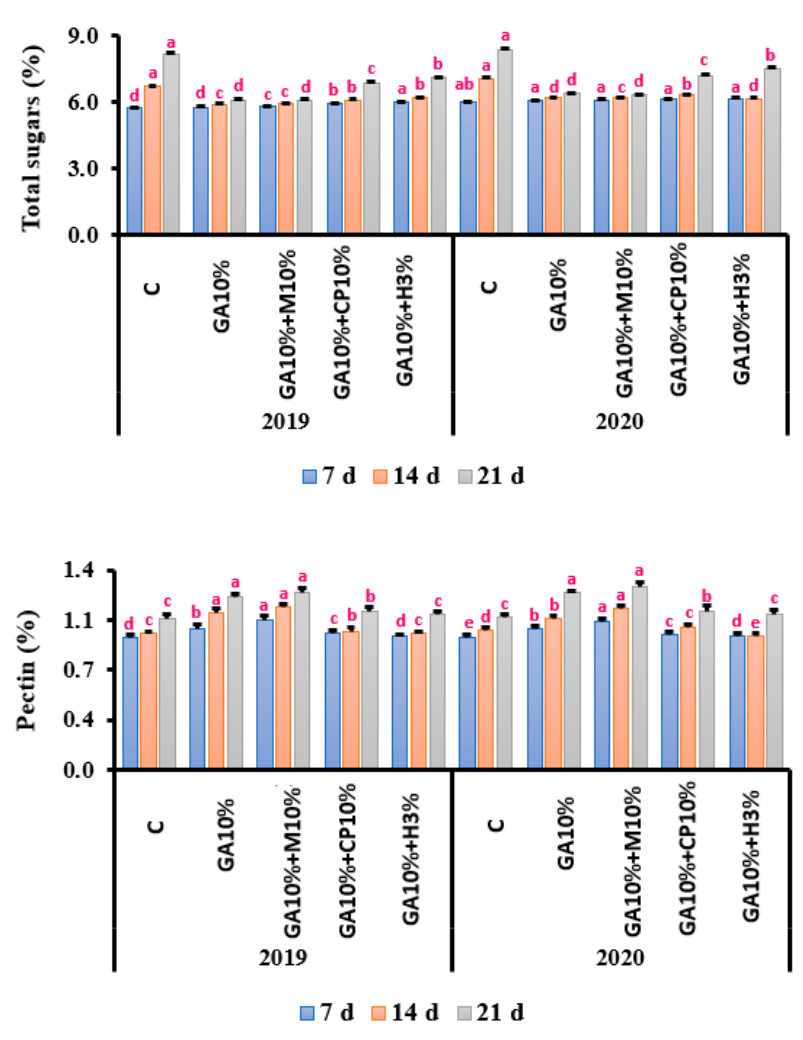
Figure 3. Effect of edible coatings—moringa extract, cactus pear, henna, and GA—on total sugars and pectin (%) of guava during cold storage for 21 days throughout two seasons (2019–2020). The superscript letters, present the significantly between effect of treatments using Duncan’s multiple range